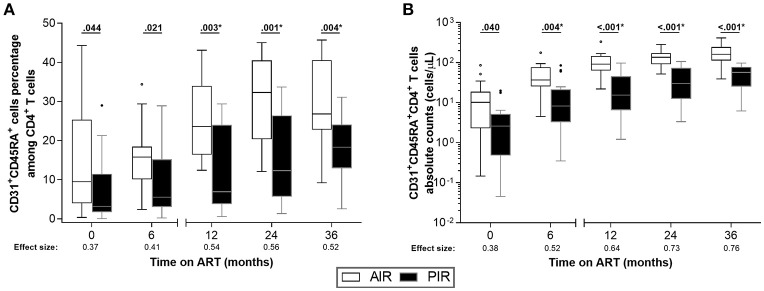
AIR had higher percentages of RTE (CD31+CD45RA+) among CD4+ T cells since baseline. (A) RTE percentage among CD4+ T cells and (B) their absolute numbers were compared throughout ART between AIR and PIR. A Wilcoxon-Mann-Whitney U-test was performed to compare the two groups of patients at each time point, and the correspondent r is presented as a measure of effect size. *Significant after Bonferroni correction (α/5 = 0.010).